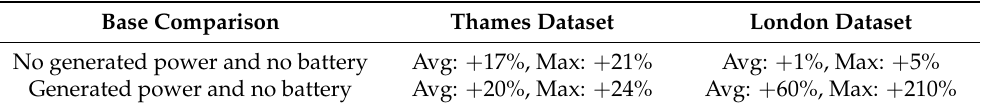
Figure 10. High-level comparison between operational profits of the baseline algorithm and smart algorithm for the average prosumer using various battery sizes across the lookahead amounts represented in boxplots, following the experiment described in Section 5.1. Table 2. Relative operational profit for the average prosumer from using the smart algorithm over the baseline algorithm in the simulated Thames or London environment. The underlying basis for comparison is no battery and/or generated power (Table